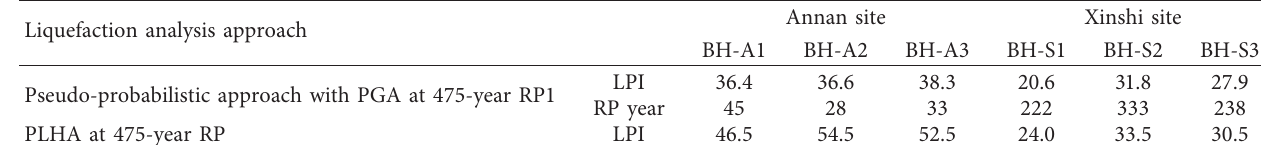
Table 2: LPI results of Annan and Xinshi sites in Tainan city.